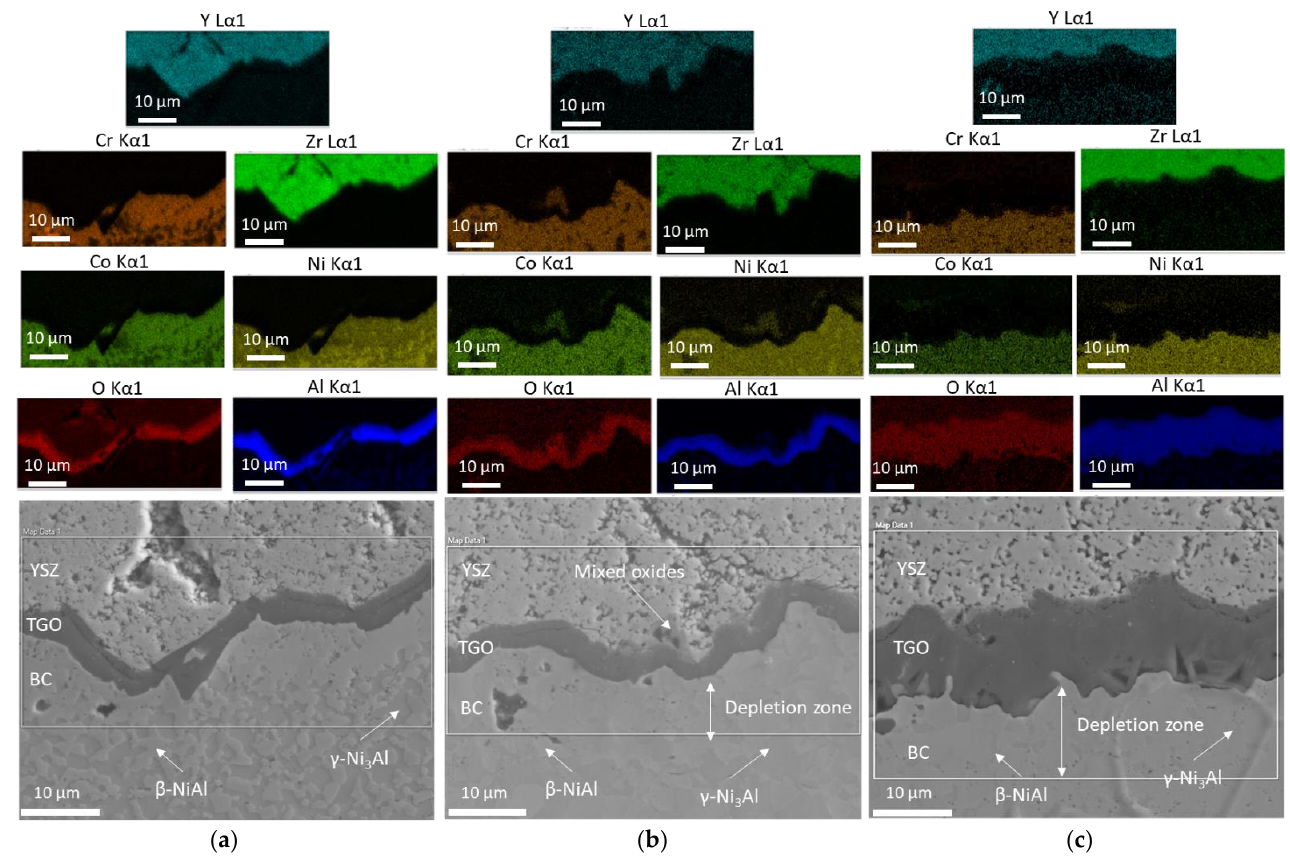
Figure 3. EDS elemental mapping of TGO region for the double layered DL TBC after ( a ) 1 h, ( b ) 10 h, ( c ) 100 h.